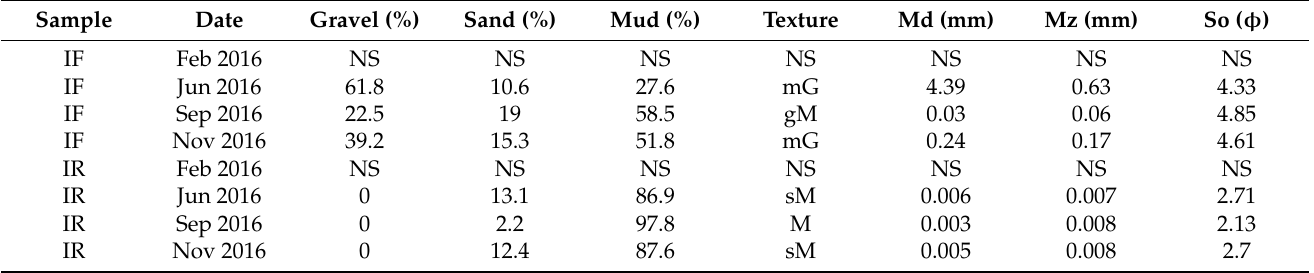
Table 1. Summarized grain size data for Ilova fishpond (IF) and Ilova River reference site (IR).